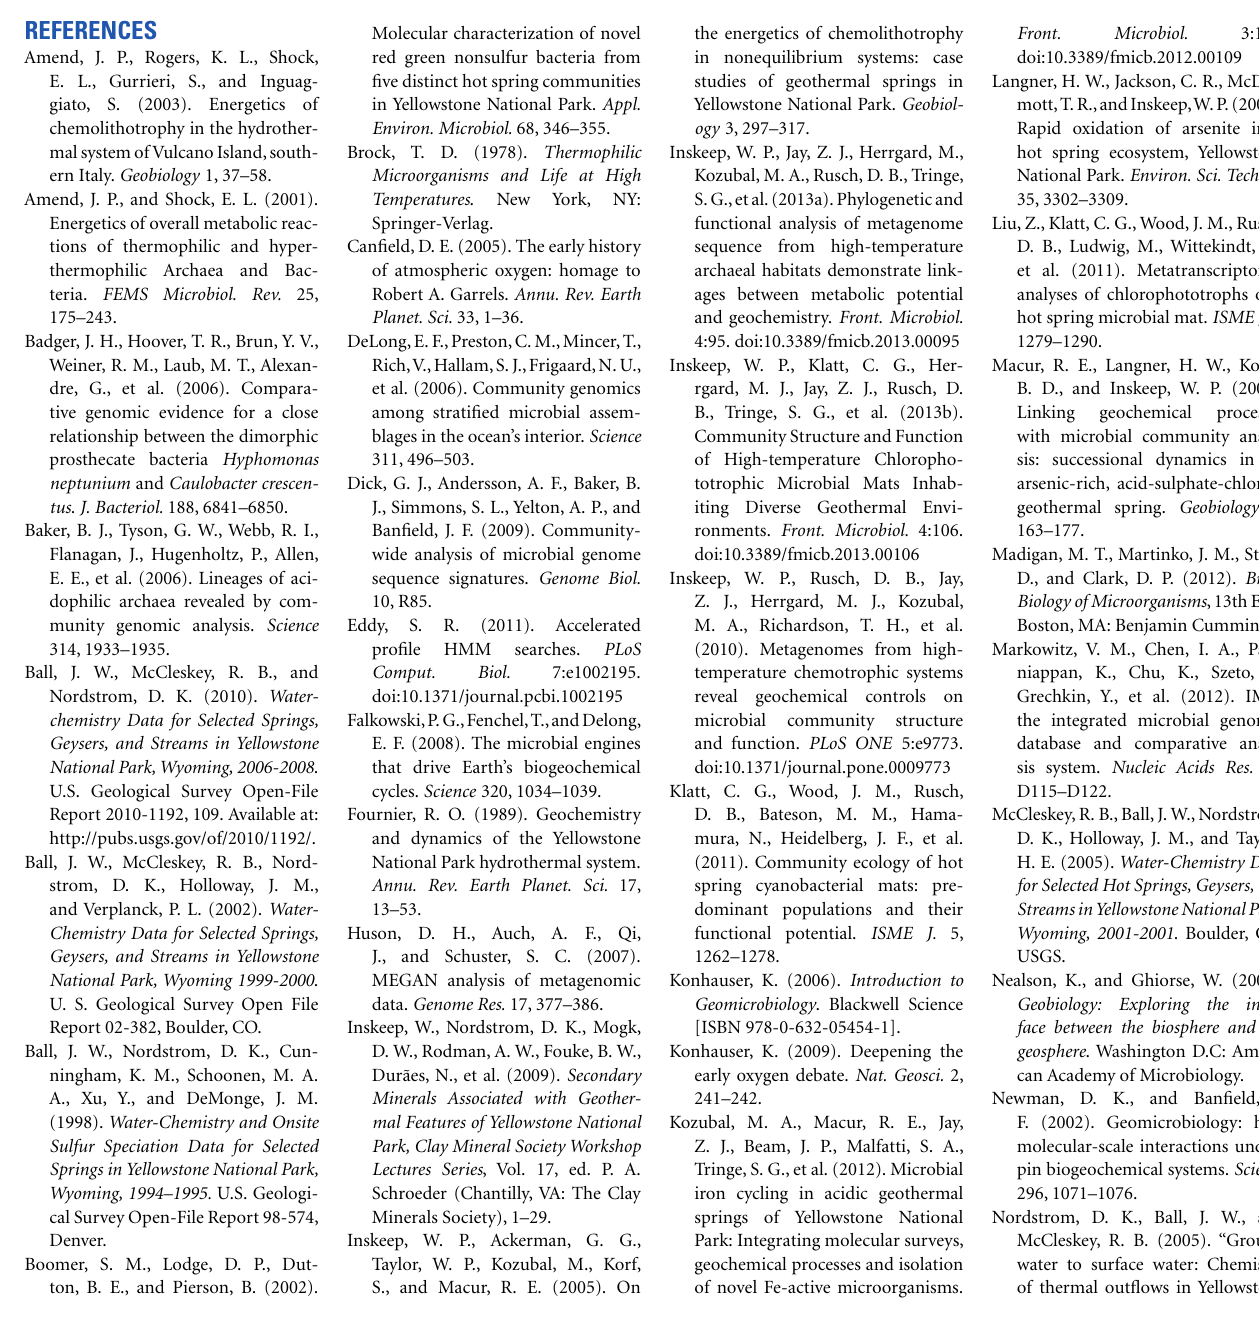
potential metabolic attributes associated with the predominant phylotypes found within these geothermal sites. Figure S1 |Additional site photographs emphasizing landscape context of geothermal habitats and field sampling efforts (included as a separate file containing 53 annotated photographs). Figure S2 |Top rankedTIGRFAM categories based on their ability to differentiate the three types of sites discussed in this study: aquificales “streamer” communities (blue), archaeal-dominated sediments (yellow),